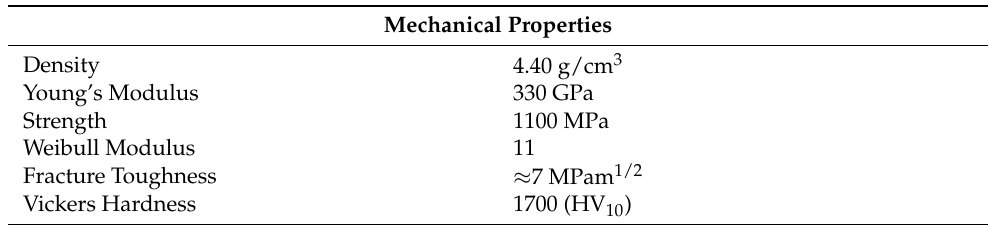
Table 5. Material properties of an alumina matrix composite containing plateles and about 25 wt-% of zirconia, partially stabilized by yttria and